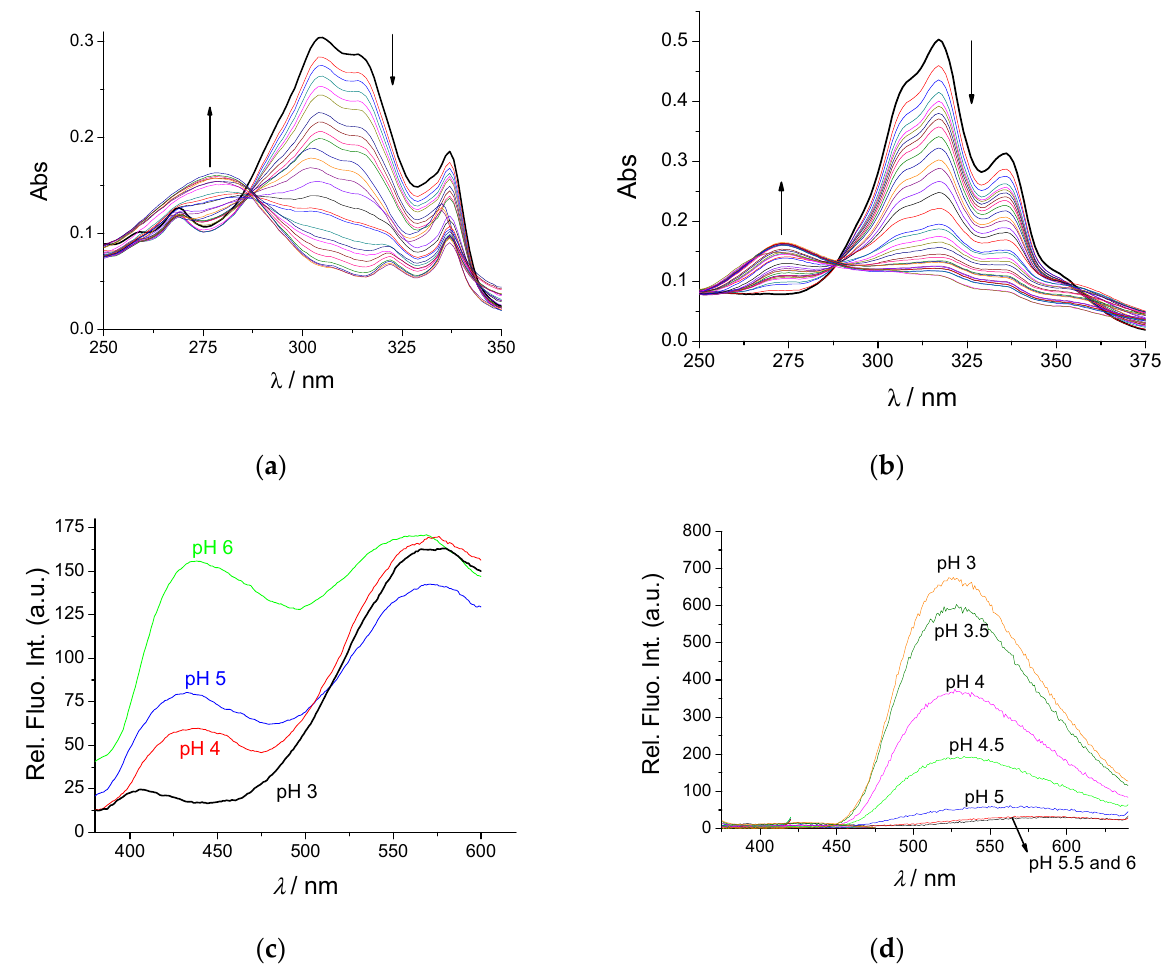
Figure 1. ( a ) Dependence of the UV/vis spectrum on pH ( c ( 1 or 2 ) = 2.0 × 10 − 5 M) of a) 1 (p K a ~5); ( b ) 2 (p K a < 4). Dependence of the fluorescence spectrum on pH ( c ( 1 or 2 ) = 1.0 × 10 − 6 M) of ( c ) 1 ( λ exc = 340 nm); ( d ) 2 ( λ exc = 332 nm). Performed in water by adjusting pH to 3 with HCl and subsequent additions of NaOH solution, simultaneously measuring pH and collecting UV/vis spectra.